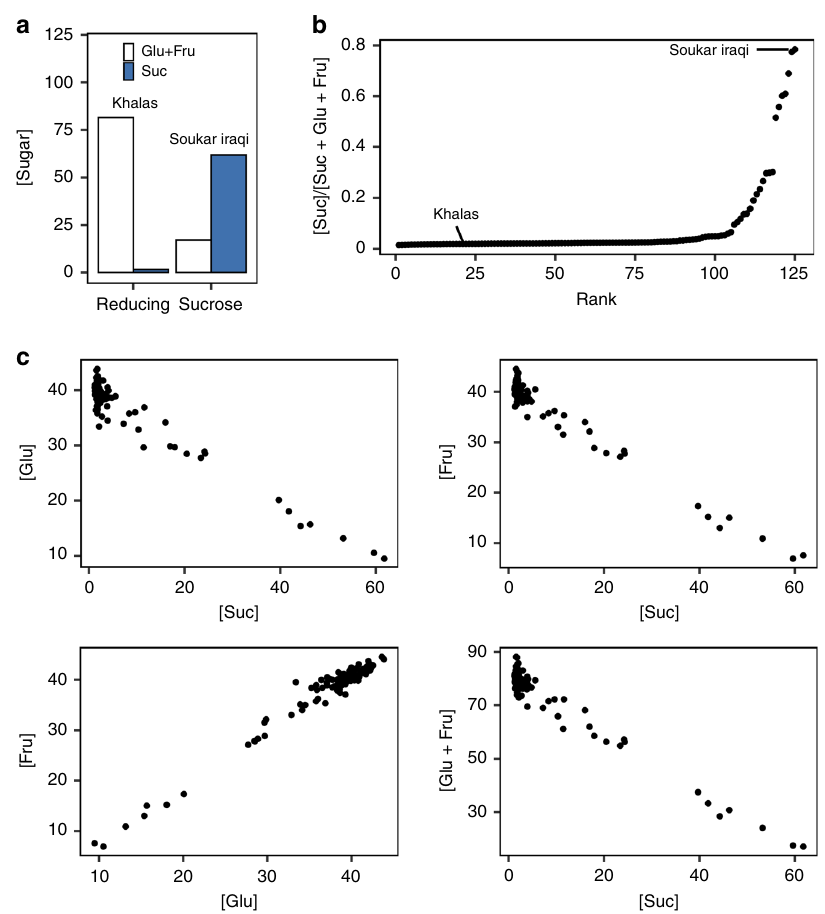
Fig. 4 Date palm fruit sugar composition phenotypes in the GWAS panel. a Sugar composition (g/100 g dry matter) of reducing-type and sucrose-type varieties Khalas and Soukar Iraqi at the tamar stage (Suc = sucrose, Fru = fructose, Glu = glucose). b Distribution of the percentage sucrose to total sugar in the mapping population. c Correlations of sugar concentrations across varieties. Source data are provided as a Source Data fi